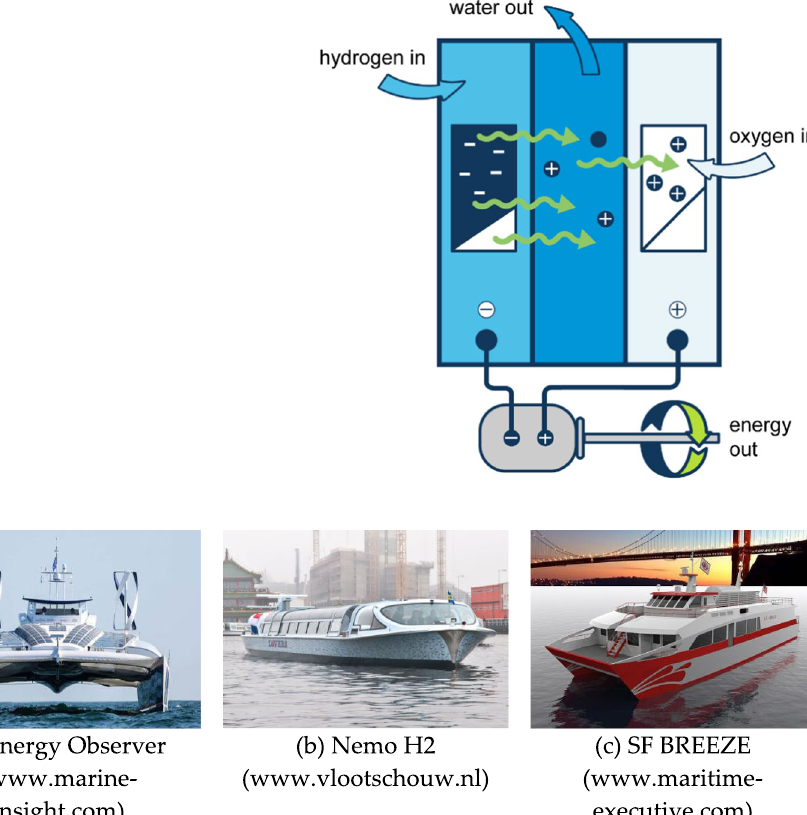
Fig. 13 Working mechanism of hydrogen fuel cell (www.